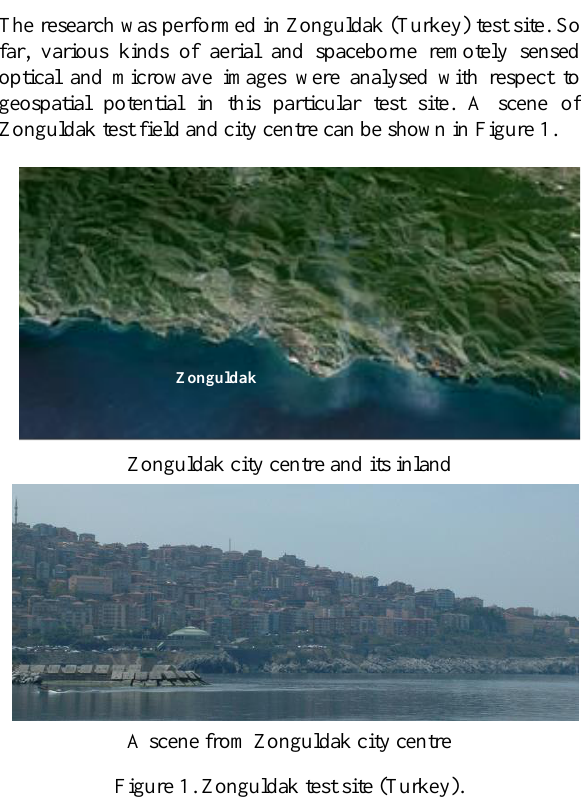
Figure 1. Zonguldak test site (Turkey).